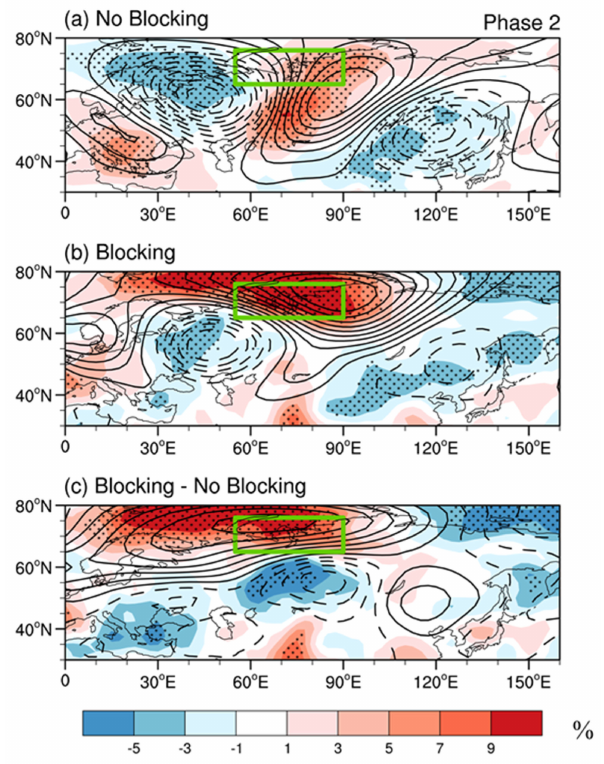
Figure 10. As in Figure 9 but for phase 2 in Eastward